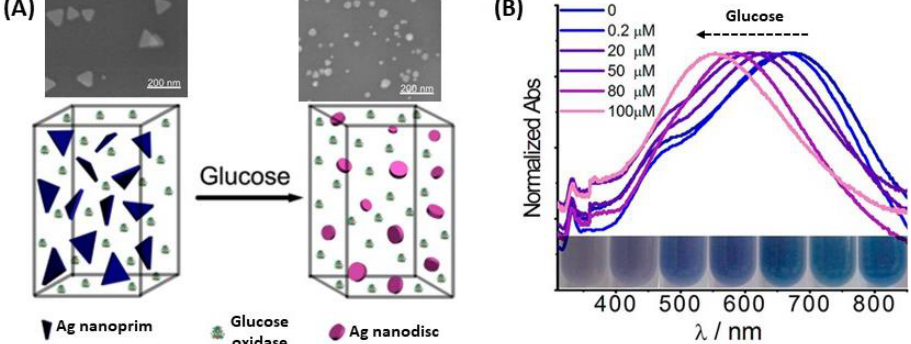
Figure 29. ( A ) Illustration of the strategy to modify the AgNPs shape from nanoprisms to nanodiscs through Ag oxidation for colorimetric sensing of glucose. SEM images of the Ag nanoprisms before and after incubation with glucose oxidase and glucose (100 μM) for 60 min are also showed. ( B ) Absorption spectra of the Ag nanoprisms after glucose incubation in various concentrations for 40 min with photographs of the corresponding suspensions. Adapted from [196]. Copyright (2013), American Chemical Society.